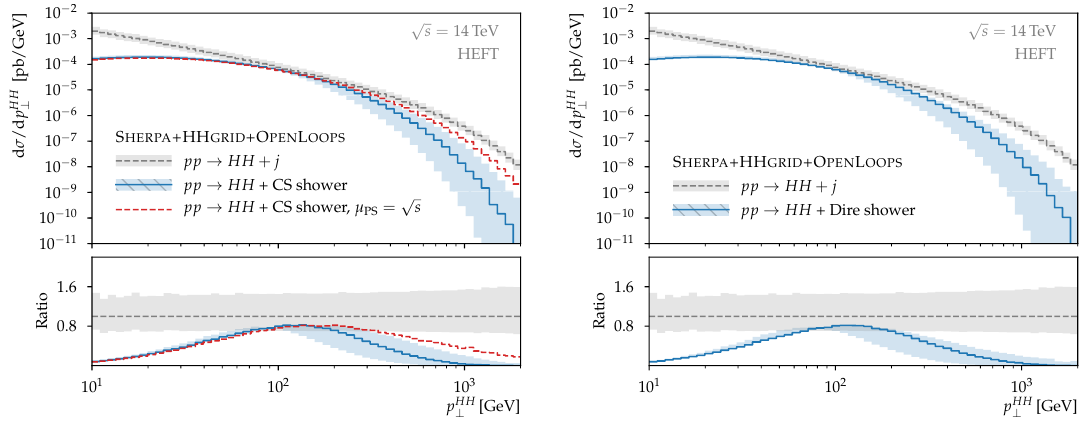
Figure 2 . Parton shower predictions for the p HH spectrum in a LO+PS type simulation compared ? to a (cid:12)xed-order calculation in the HEFT approximation. The uncertainty band around the (cid:12)xed- order result is obtained by varying (cid:22) F and (cid:22) R . Uncertainties on the LO+PS results are obtained by varying (cid:22) PS